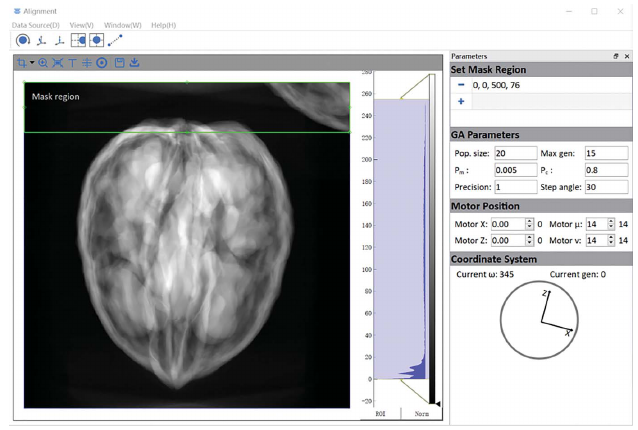
Figure 9 GUI of the alignment